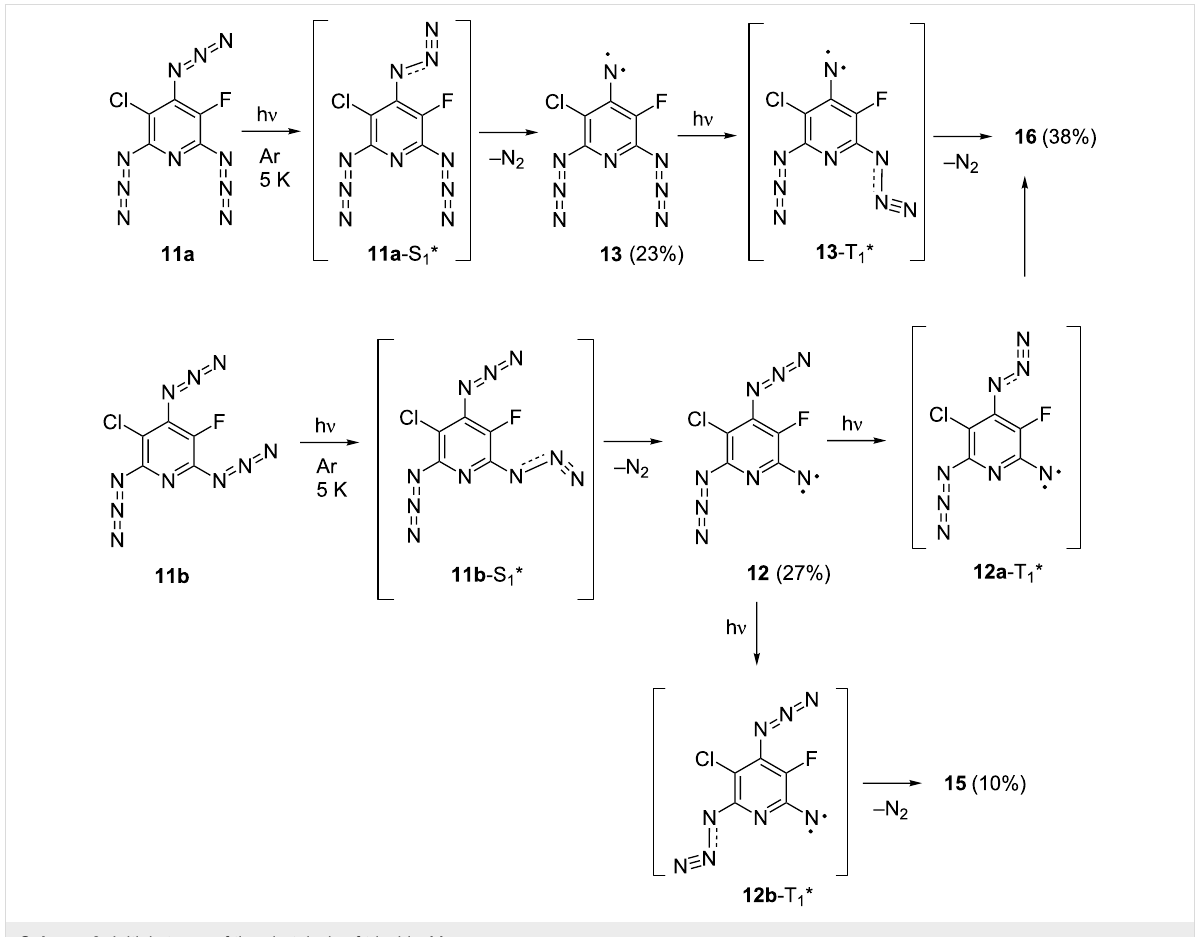
Scheme 3: Initial stages of the photolysis of triazide 11 .